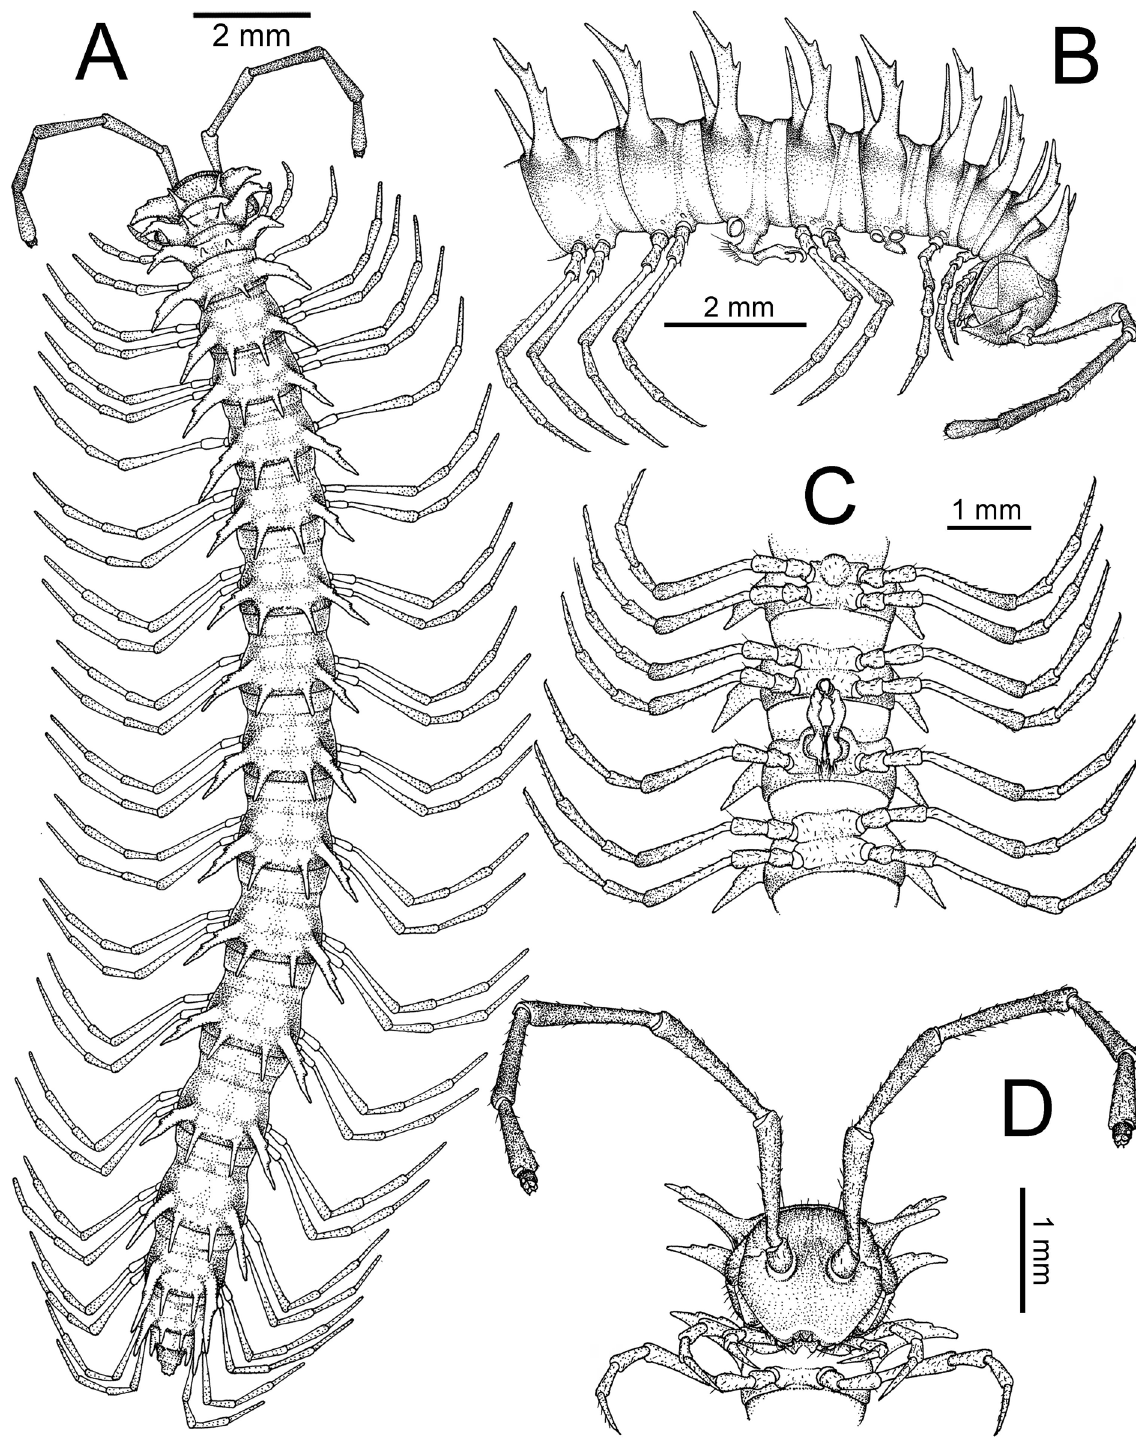
Fig. 2. General body characters of Nagaxytes Srisonchai, Enghoff & Panha gen. nov. – N. acantherpestes (Golovatch & Enghoff, 1994) gen. et comb. nov., ♂, holotype, Prachuap Khiri Khan Province, Hua Hin District (ZMUC 000101457). A . Entire body. B . Anterior body part. C . Body rings 5–8, showing sternal lobe between coxae 4 and gonopods on ring 7. D . Head and